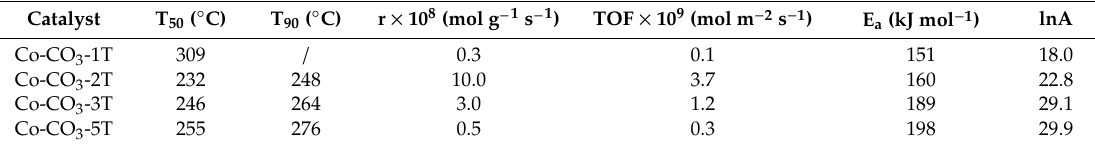
Table 3. Catalytic performance and kinetic analysis of the catalysts for toluene oxidation.